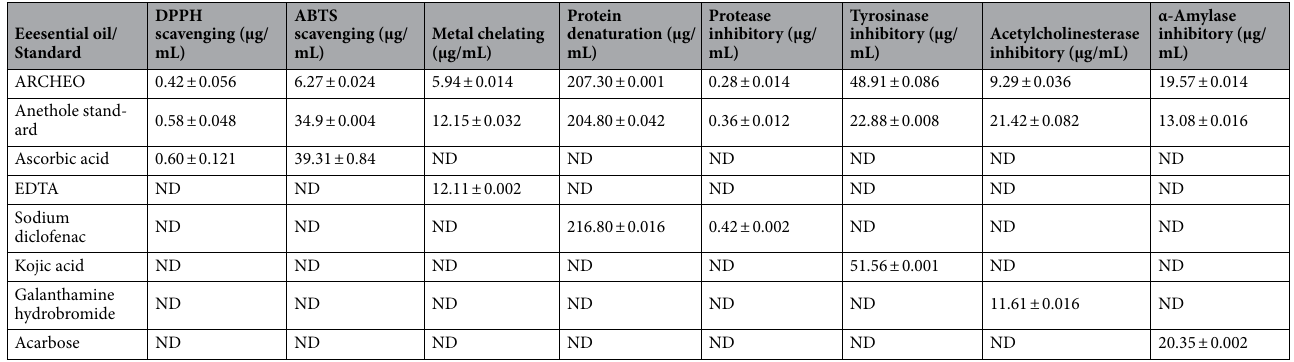
Table 4. 50% Inhibition concentrations (IC 50 ) determination values for pharmacological activities of ARCHEO, and standards using Graph Pad Prism software. ARCHEO anethole rich C. heptaphylla essential oil, ND not